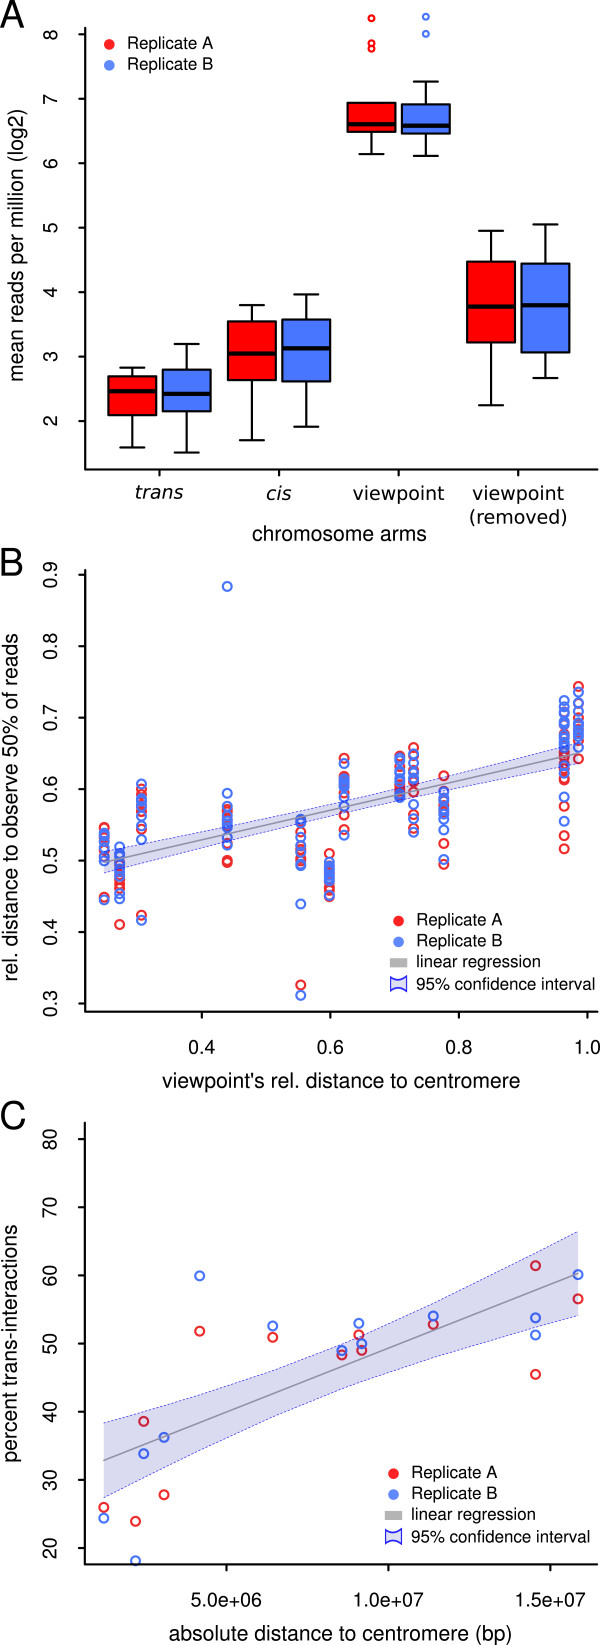
Physical constraints of chromosomal architecture. (A) Number of reads per million for four distinct classes of interactomes. Viewpoint: circular chromosome conformation capture (4C) reads that map on the same chromosome arm as the viewpoint. Viewpoint (removed): interactions mapping the viewpoint’s arm, excluding interactions that map within 2 Mb distance on either side of the viewpoint. Cis: 4C reads that map to the other arm of the chromosome harboring the viewpoint. Trans: 4C reads that map to all other chromosome arms. (B) The relative distance to the centromere (0 at the centromere, 1 at the telomere) in which 50% of the 4C reads can be found depends on the relative distance of the viewpoint to the centromere. (C) The percentage of 4C reads that can be mapped to trans arms was positively correlated with the viewpoint’s absolute distance to the centromere in base pairs (bp). In all parts, red circles represents replicate A, blue represents replicate B.